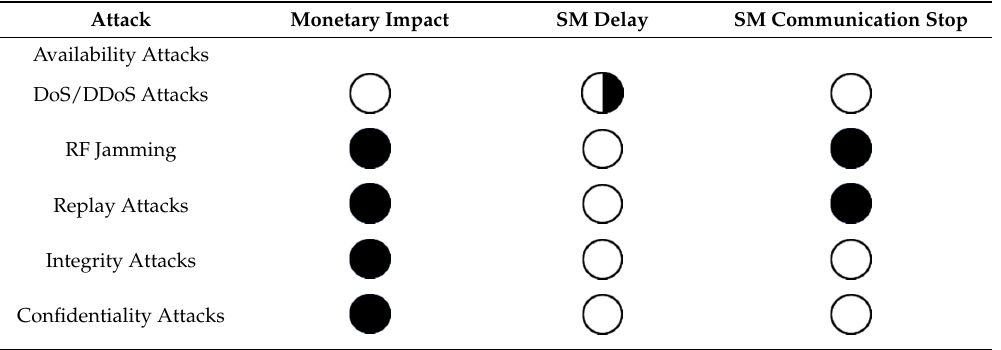
Table 9. Comparison of severity of attacks.